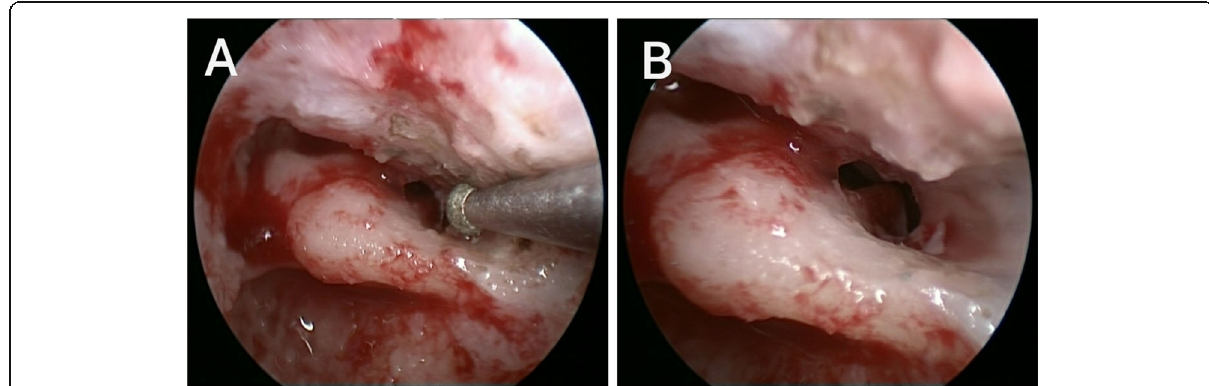
Fig. 1 a Endoscopic view of the right ear showing the drilling of a limited posterior attico tympanotomy using a 1.5-mm diamond burr in order to create a connection between the epitympanic tunnel and ME. b The final view of the drilled space between the lateral edge of the short process of the incus and the posterior canal wall till exposing the incudo-stapedial joint